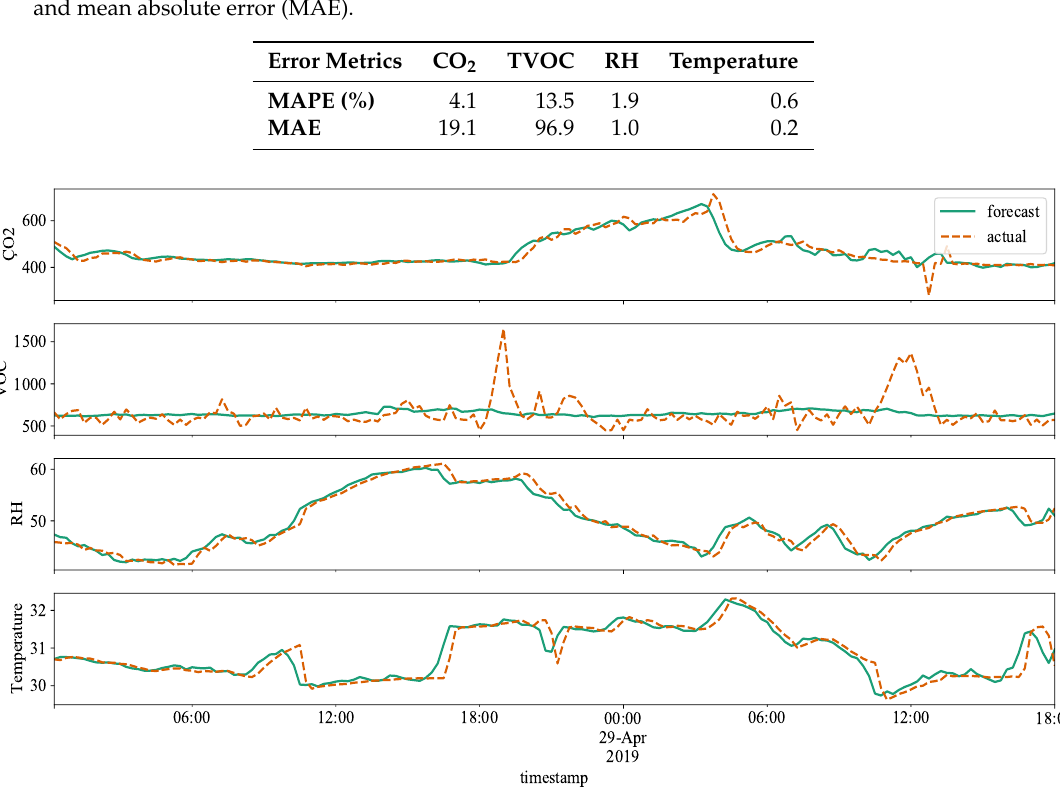
Figure 8. Visualization of IAQ sensor forecasting using CNN